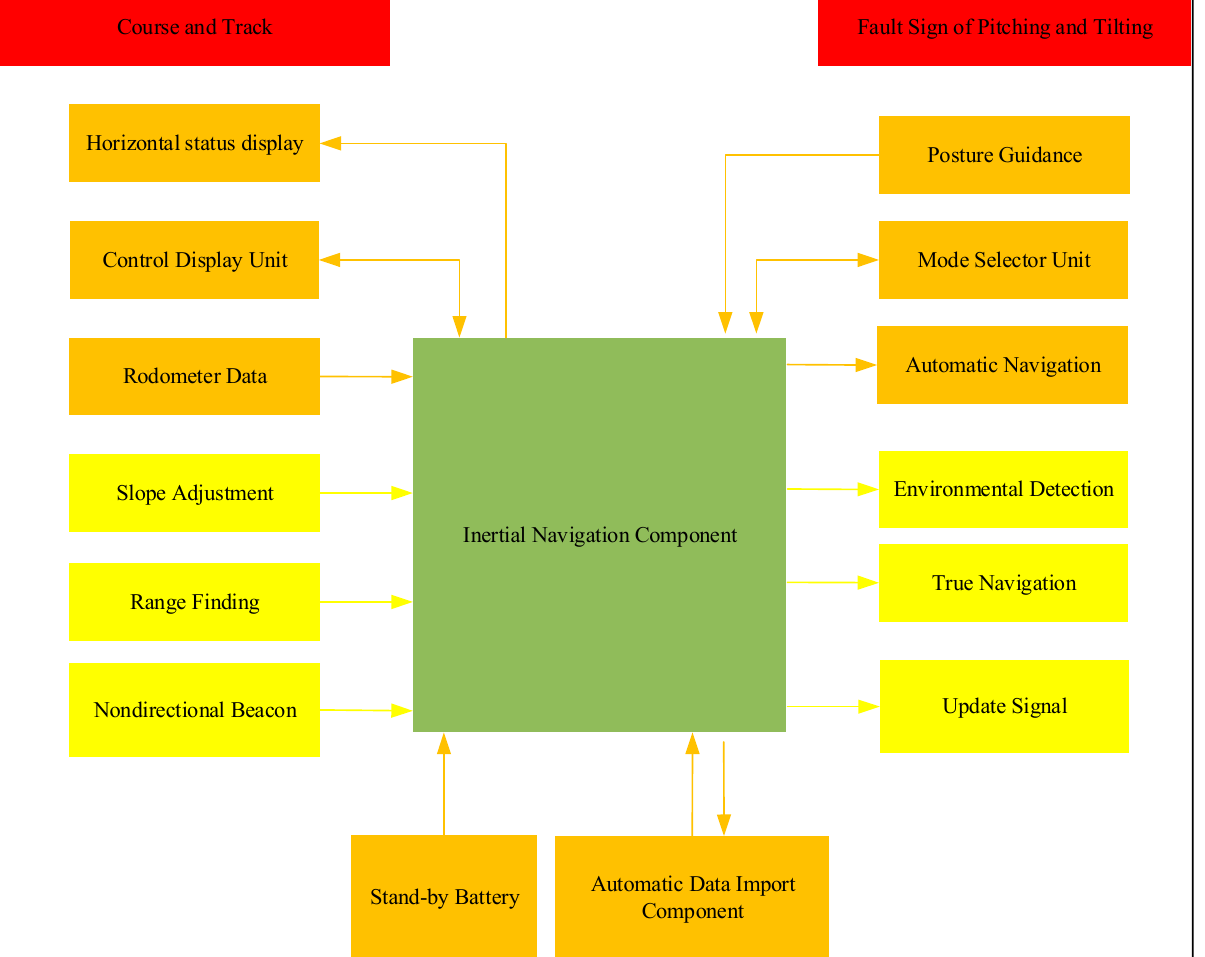
Figure 4. Schematic diagram of hydraulic support and machine automation. 5.3. Centralized Control Technology of Fully-Mechanized Mining Equipment Figure 5 shows the process control model of fully mechanized mining equipment. Figure 6 shows the picture of the centralized control software for fully-mechanized min- ing equipment. Figure 6a is the coal wall monitoring system, which collects coal wall conditions in real time through video; Figure 6b is the hydraulic pump monitoring sys- tem, which realizes the visualization of hydraulic data of the hydraulic support, and Figure 6c is the coal shearer monitoring system, which can monitor the shearer drum in real time. In the roof condition, Figure 6d shows that the shearer detection system moni- tors the relevant data of the shearer, such as shearer speed, traction current, load cutting